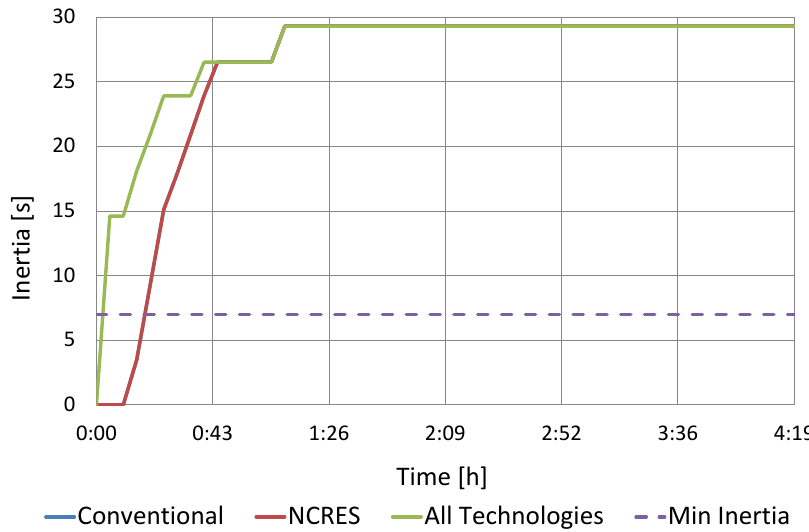
Figure 13. Cumulative inertia of the